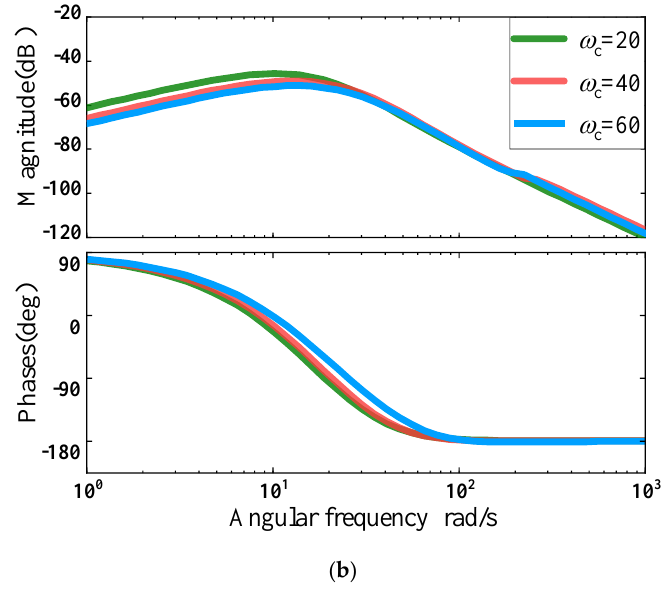
Figure 8. Improved LADRC regulation parameters affected the antidisturbance performance porter diagram. ( a ) Comparison of Porter diagrams of anti-interference performance for parameter ω 0 adjustment effects; ( b ) comparison of Porter diagrams of anti-interference performance for parameter ω c adjustment effects.